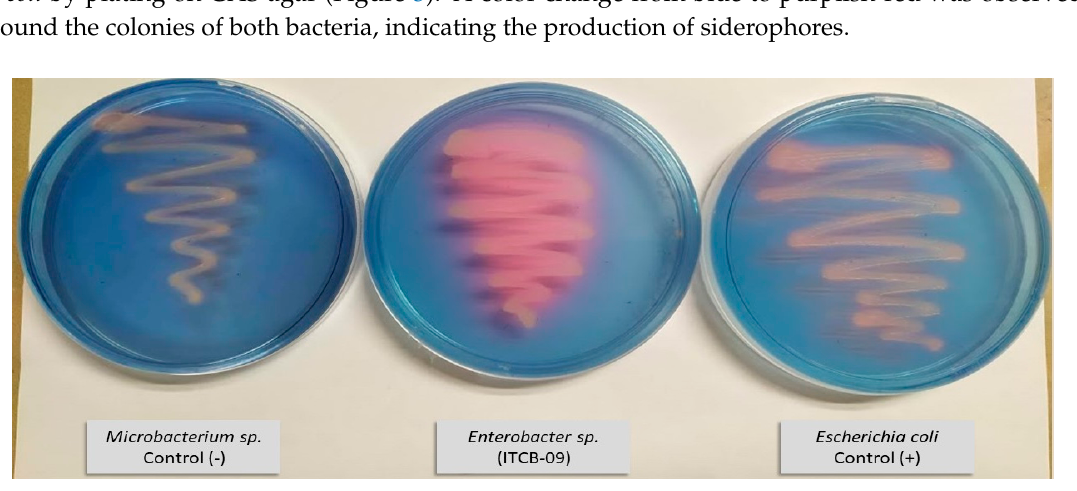
Figure 3. Culture on CAS medium of E . coli and Enterobacter sp. ITCB-09.